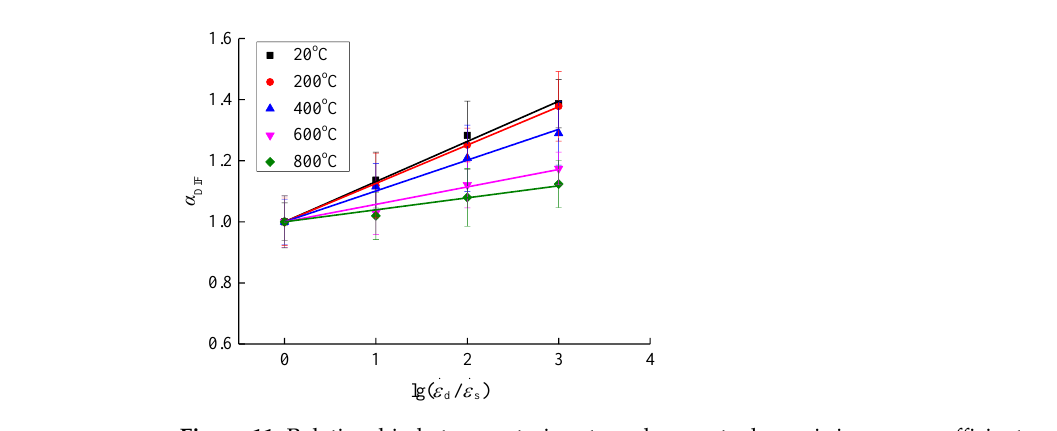
Figure 10. Relationship between strain rate and concrete compressive stress.